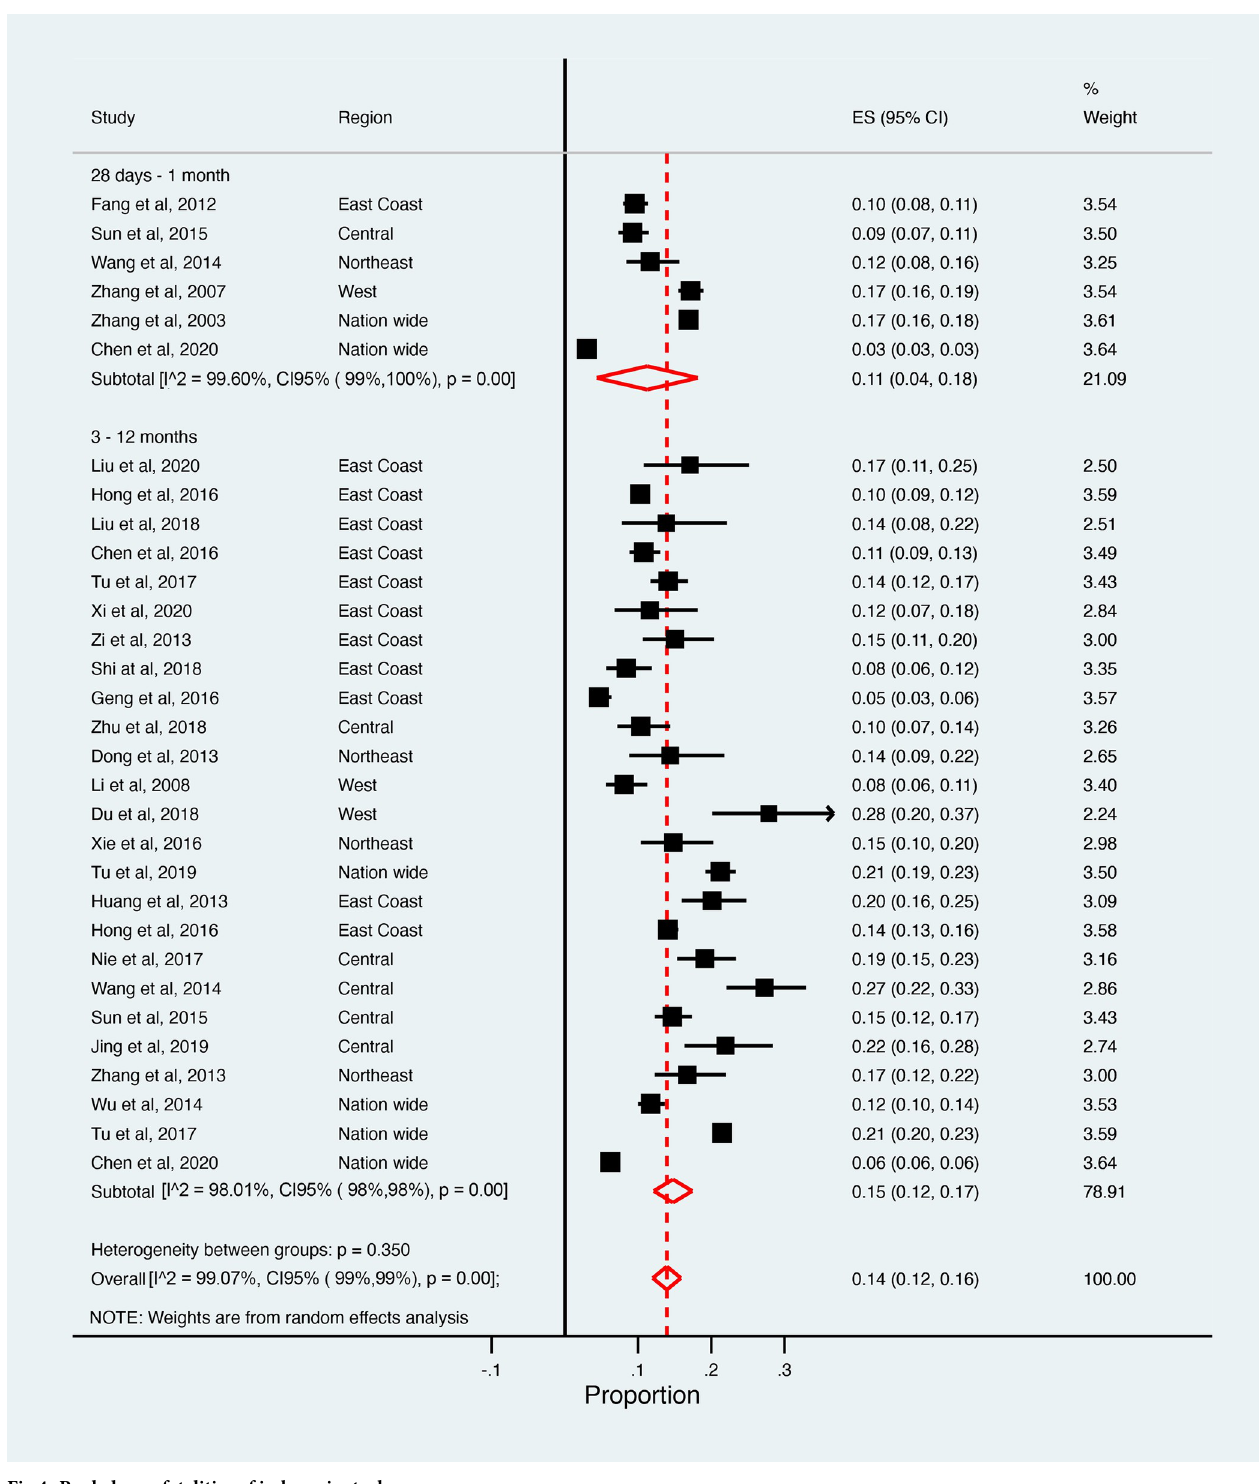
PLOS ONE | https://doi.org/10.1371/journal.pone.0270554 June 27,